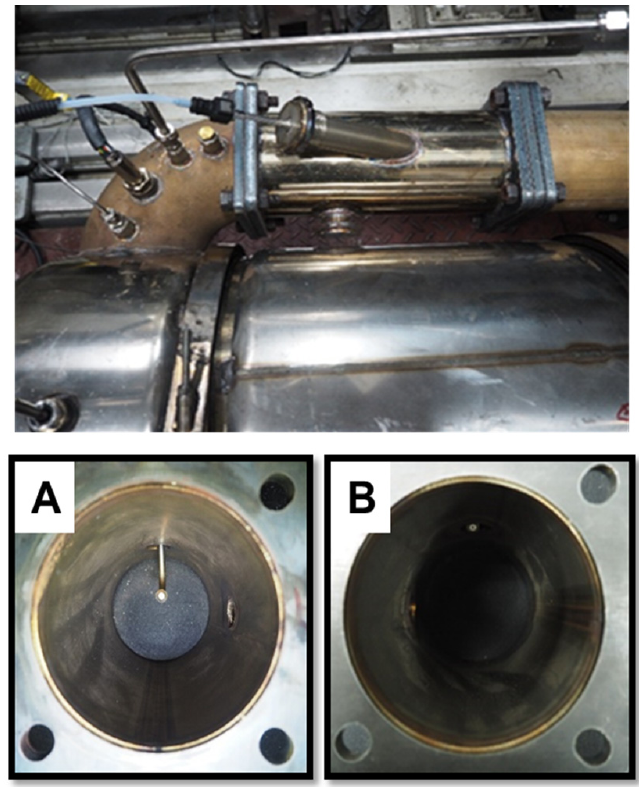
Figure 13. The urea injectors inside the SCR system: ( A ) L-type (original type) and ( B ) I-type (improved type).